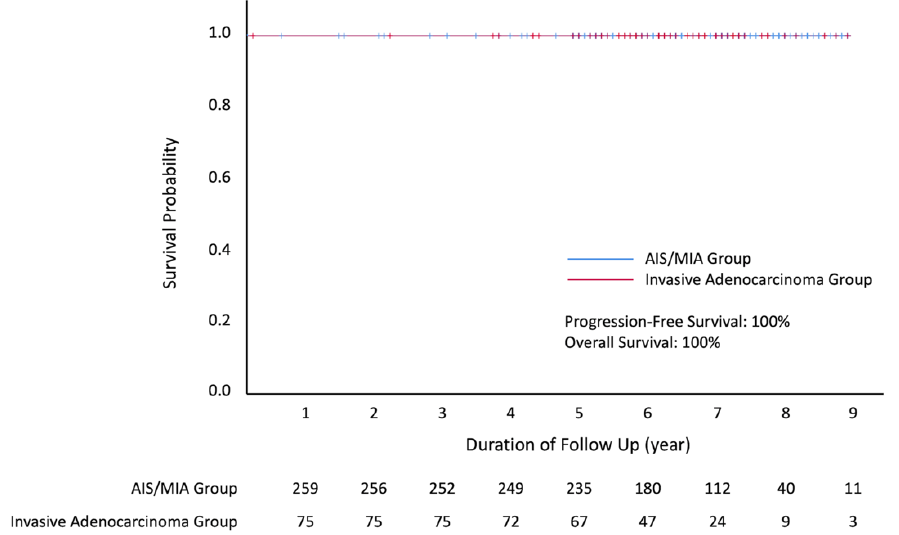
Figure 4. Kaplan–Meier curves of progression-free and overall survival for the adenocarcinoma in situ/minimally invasive adenocarcinoma group and invasive adenocarcinoma group. Table 3. Perioperative and post-operative outcomes.